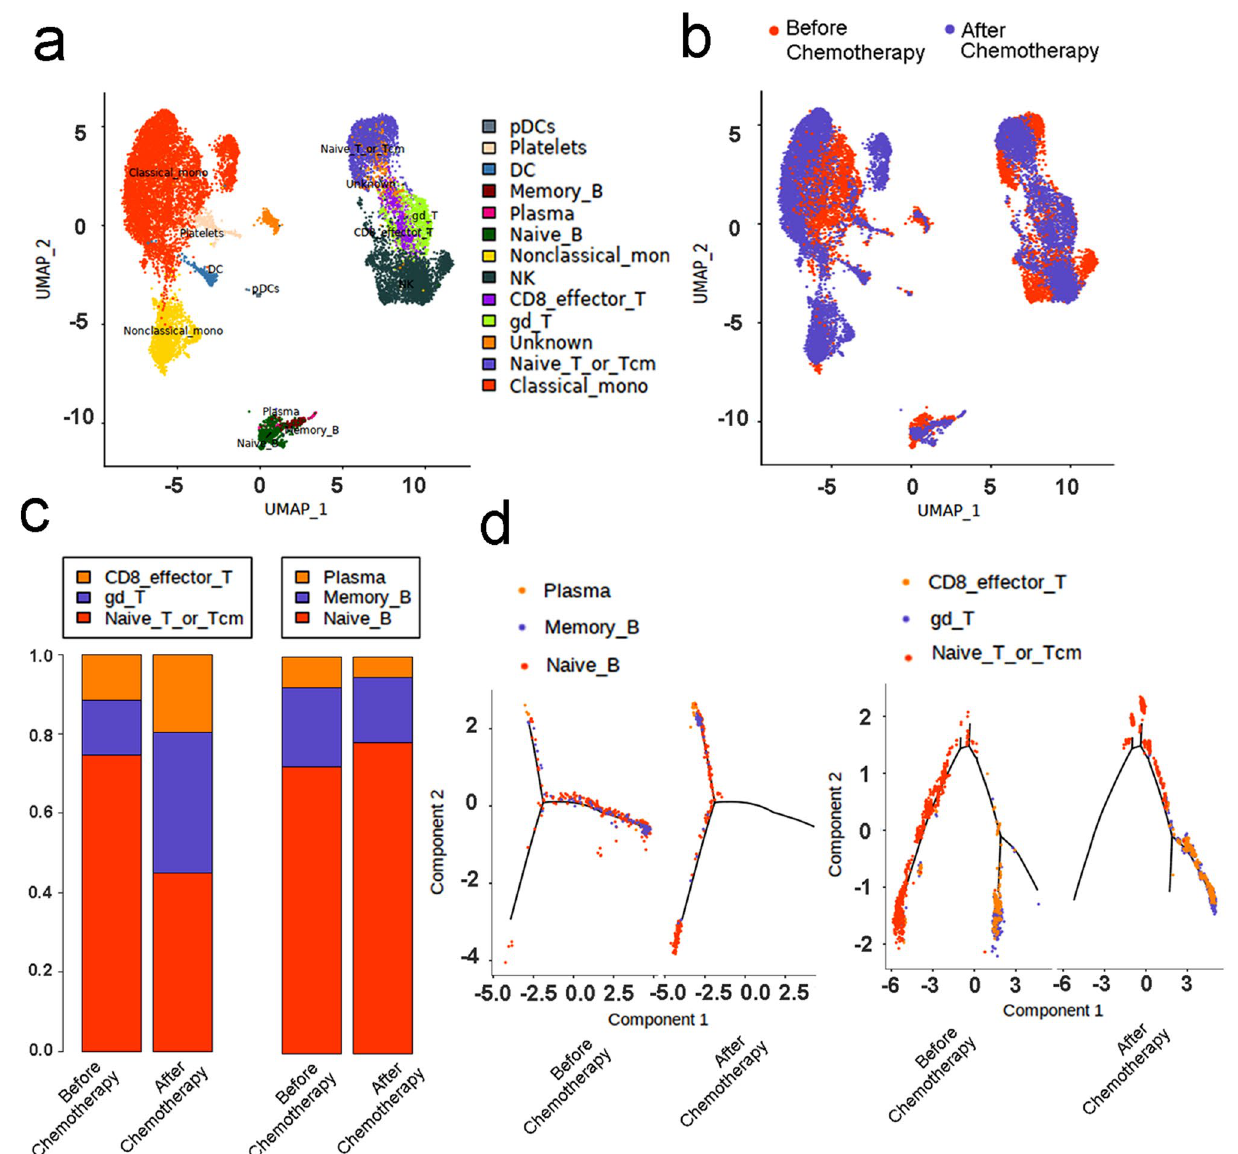
Figure 2. Dynamic study for the immunologic features in a representative patient infected by SARS-CoV-2 for more than 1 year. This 57-year-old male patient was diagnosed with non-small-cell lung cancer (stage: IIIA) and SARS-CoV-2 infection on February 25, 2020. After recovery from COVID-19, he underwent four chemotherapy cycles (500 mg/m 2 pemetrexed combined with 75 mg/m 2 Nedaplatin) from August to September 2020. The single-cell sequencing blood collections were conducted both before the chemotherapy (April 16, 2020) and after the chemotherapy (February 28, 2021). (a) UMAP projection of clusters by cell type (15, 015 cells), different colors corresponding to different cell types. (b) UMAP projection of clusters by sample source, red: before chemotherapy; blue: after chemotherapy (February 28, 2021). (c) Percentage of cell composition of each sample before and after chemotherapy; left: proportion of different T cell subset; right: proportion of different B cell subsets. (d) The Monocle 2 trajectory plot showing the dynamics of T cells (left) and B cells (right) in the patient before and after